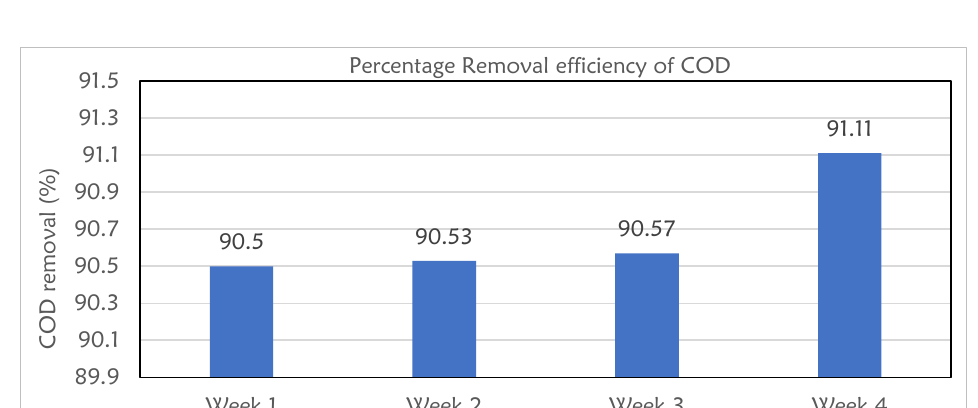
Figure 10: BOD Performance.